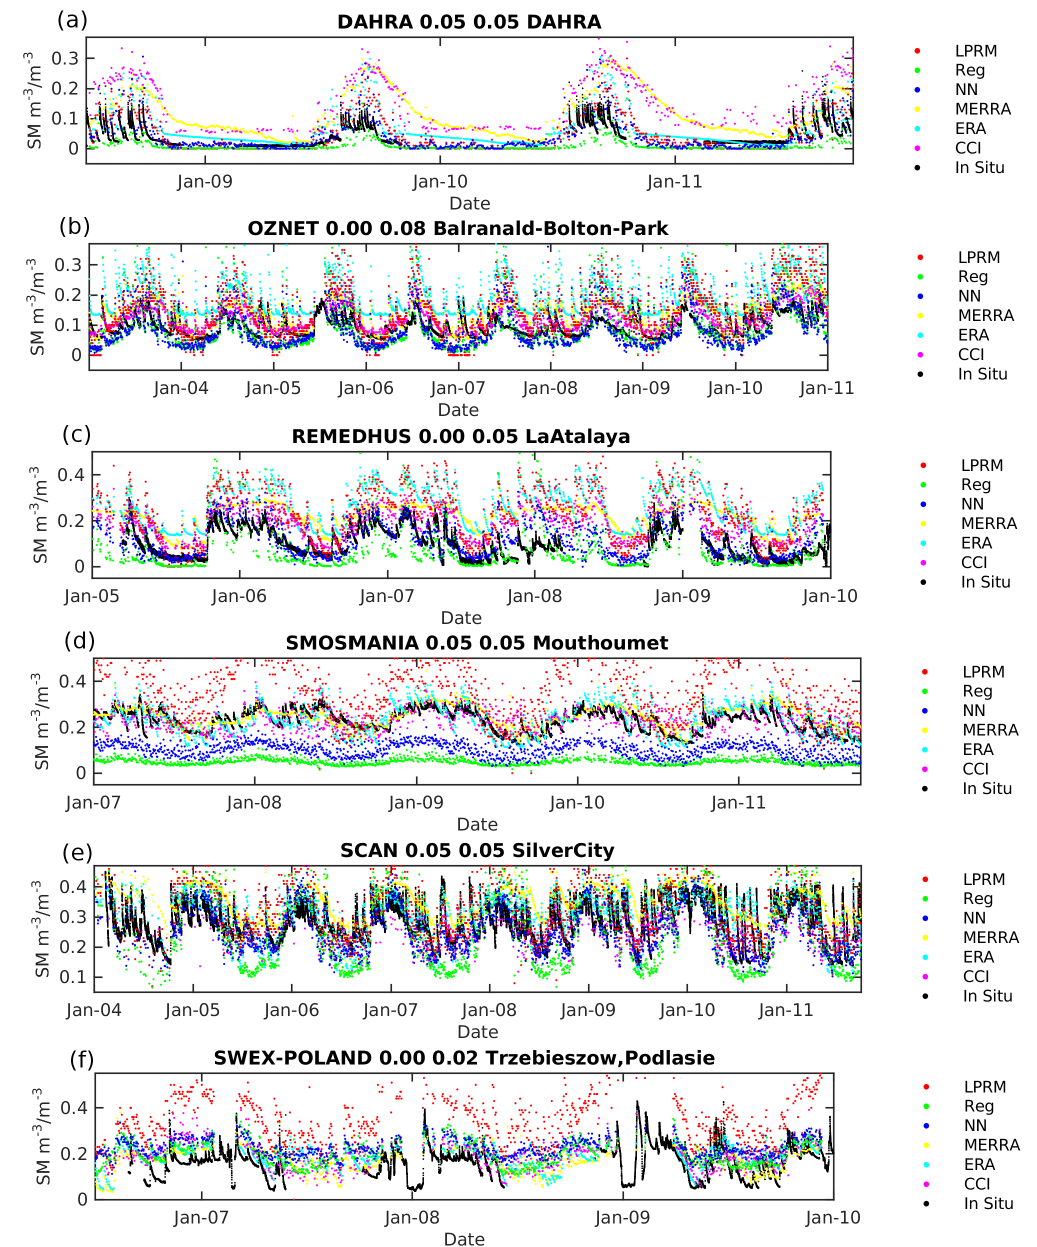
Figure 11. ( a – f ) Examples of time series: in situ measurements (black), AMSR-E NN (blue), AMSR-E LPRM (red), AMSR-E Reg (green), CCI (magenta), ERA-Land (cyan) and MERRA-Land